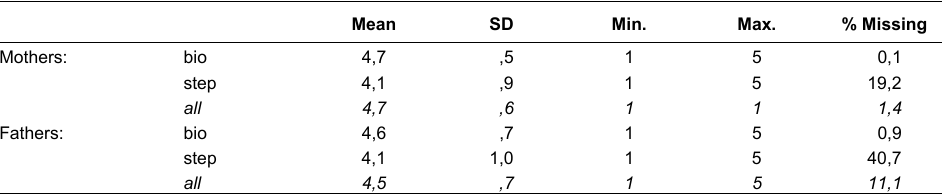
Descriptive statistics for the dependent variables (relationship assessment to resident fathers, mothers) Mean SD Min. Max. %